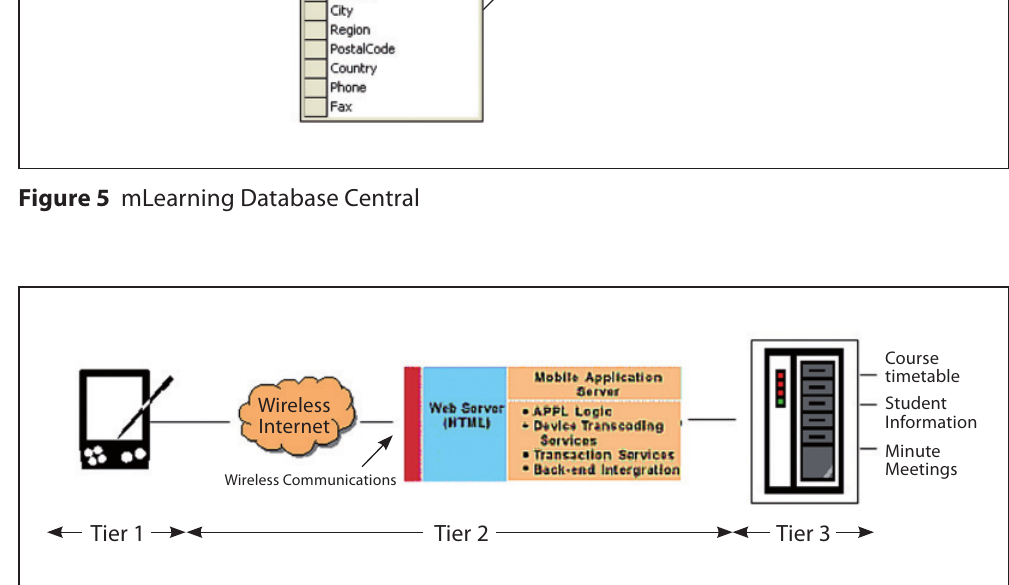
Figure 6 Learning tier and technology tier in mLearning